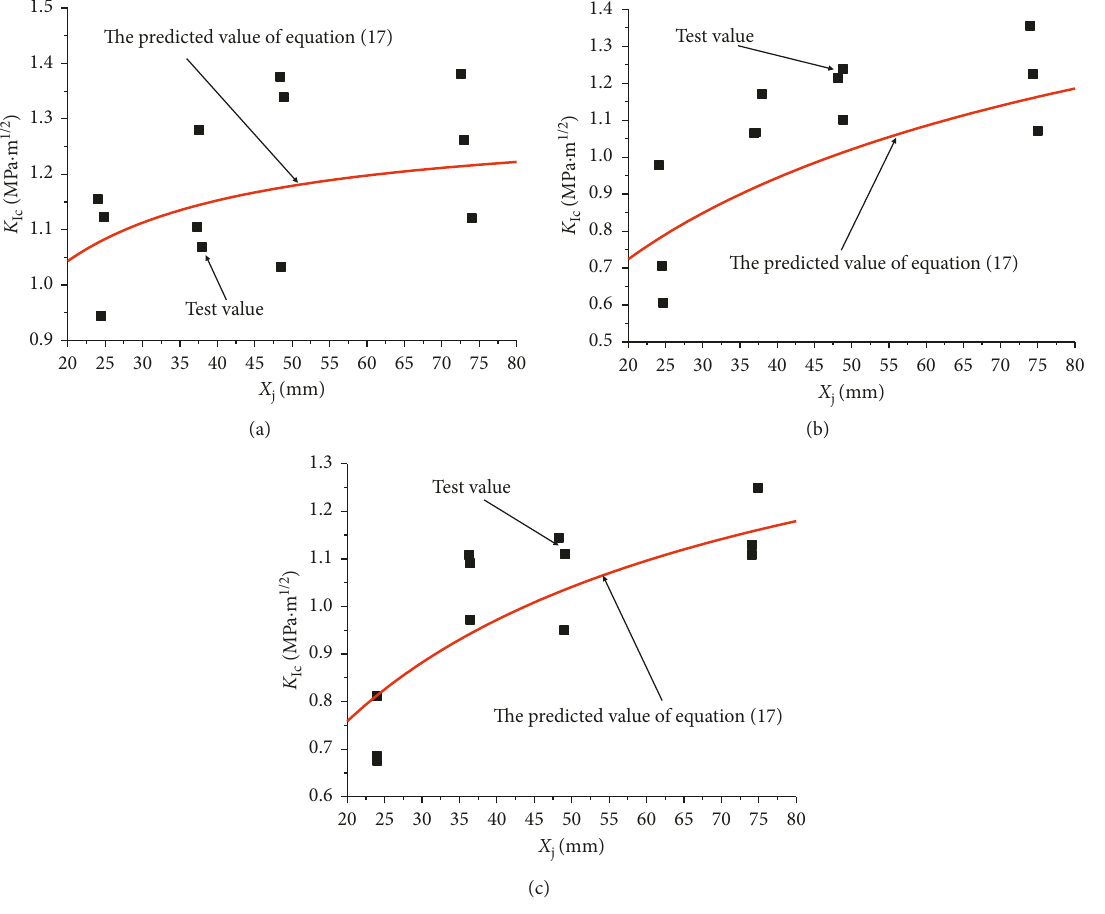
Figure 6: NSCB scale law equation curves and test values. (a) α � 0.4. (b) α � 0.5. (c) α � 0.6. Table 3: Analysis of the equation